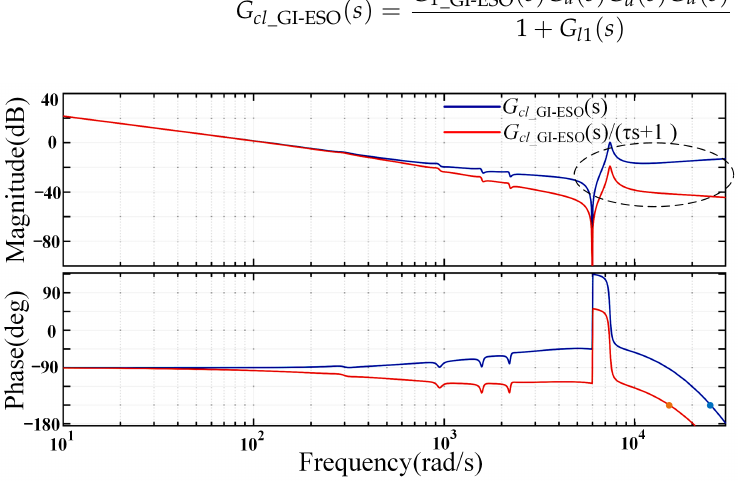
Figure 9. Bode diagram of the transfer function G cl _GI-ESO ( s ) and its low-pass